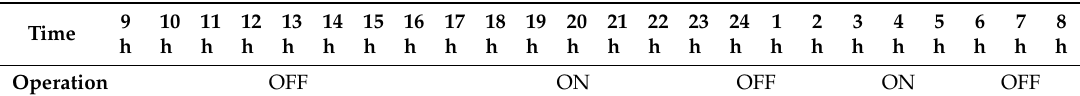
Table 5. Hot water boiler operating schedule.